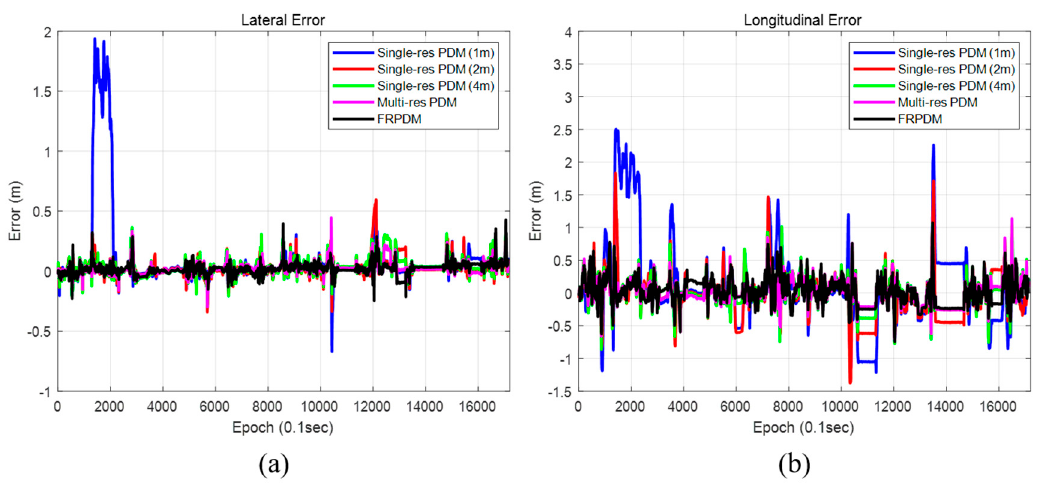
Figure 31. Position error (map type). ( a ) Lateral position error, ( b ) Longitudinal position error.